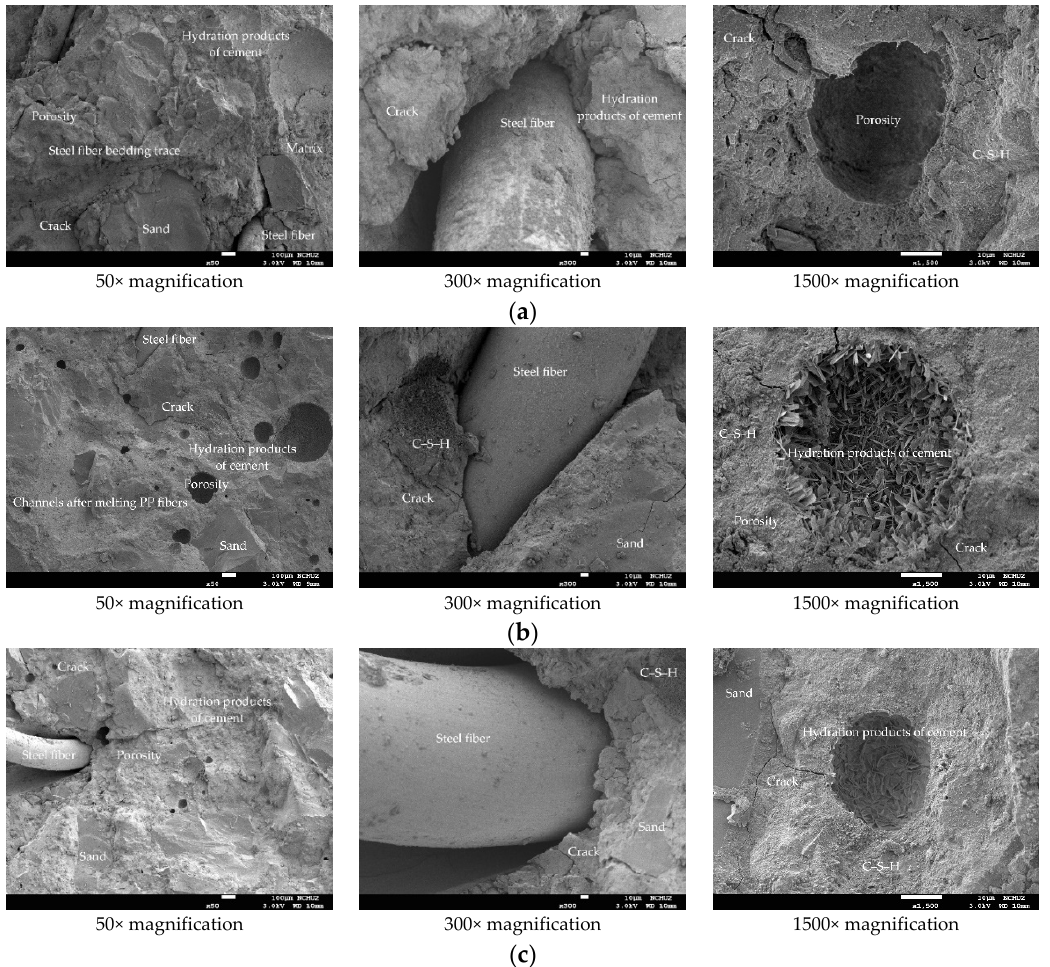
Figure 16. SEM observations of the UHPC sample after being subjected to high temperatures: ( a ) 300 °C, ( b ) 400 °C, and ( c ) 500 °C.